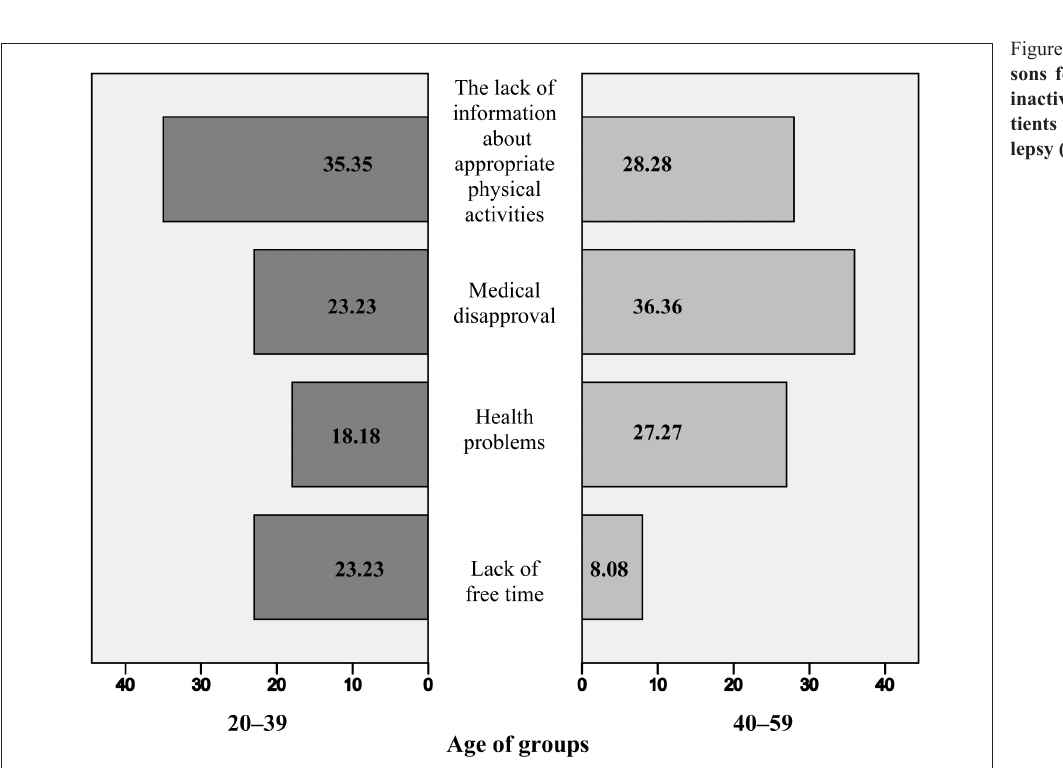
Figure 3. The rea- sons for